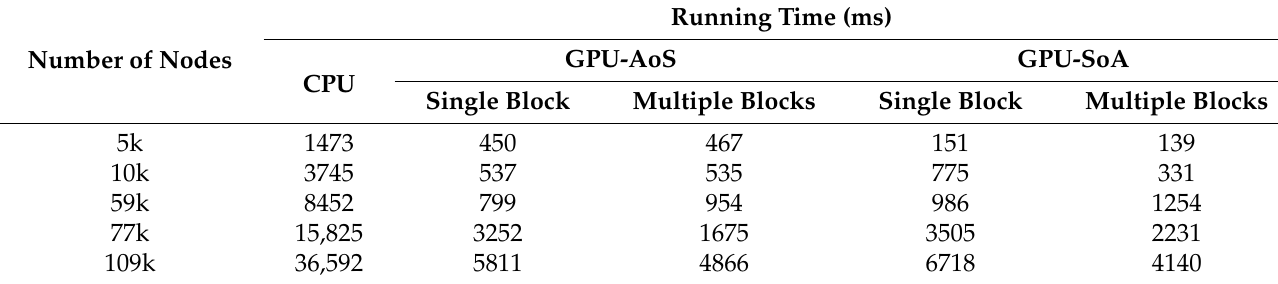
Table 3. Running time of the proposed algorithm when using Form A.